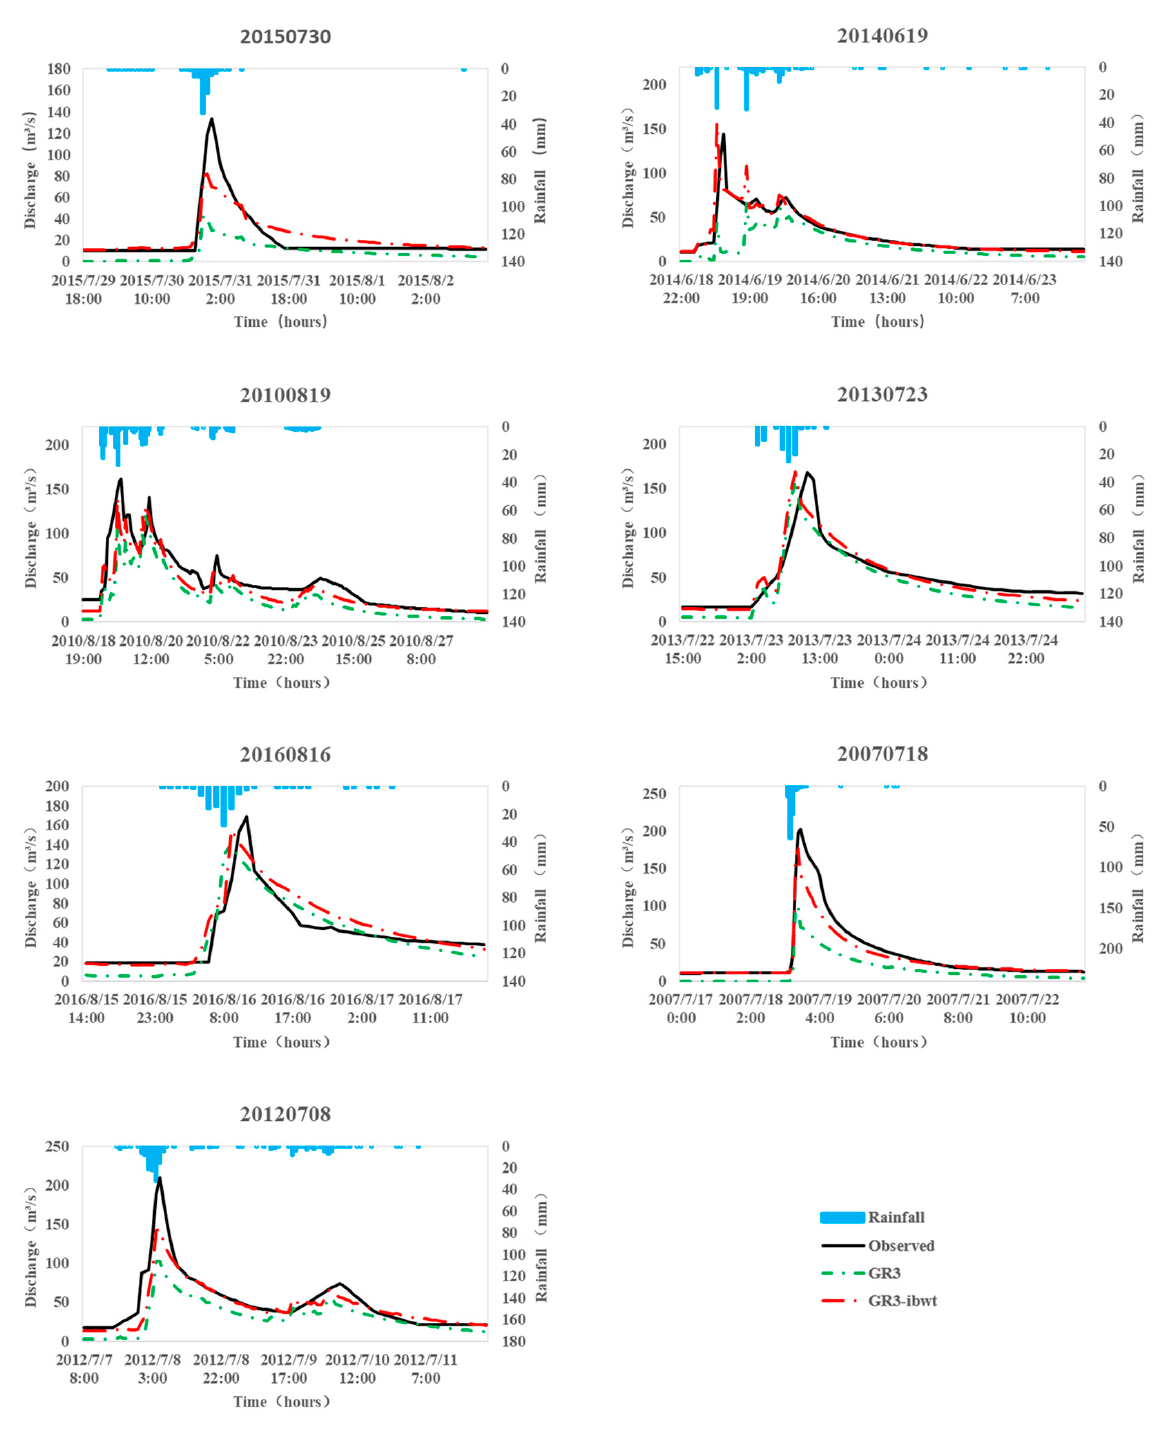
Figure 6. Time history of discharge at the outlet gauging station in big flood processes .